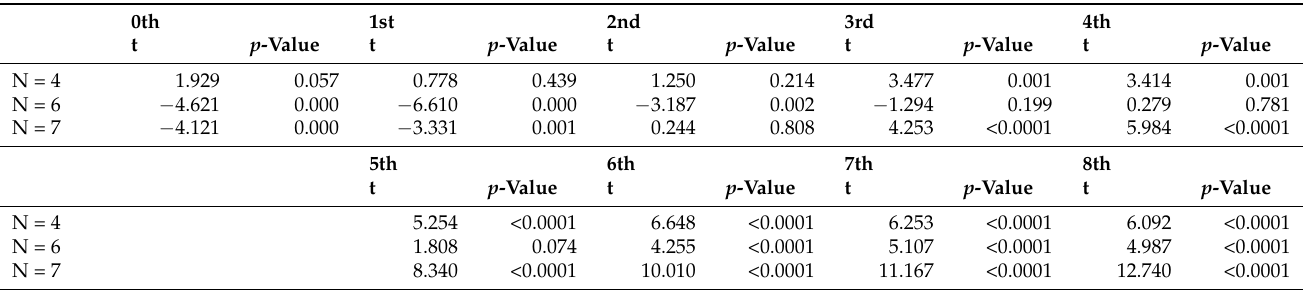
Table 1. Paired t -test of the differences of the PSNRs for different numbers of convolutional layers, N, in comparison to the five convolutional layers of the optimized self-supervised 3D-GAN EC